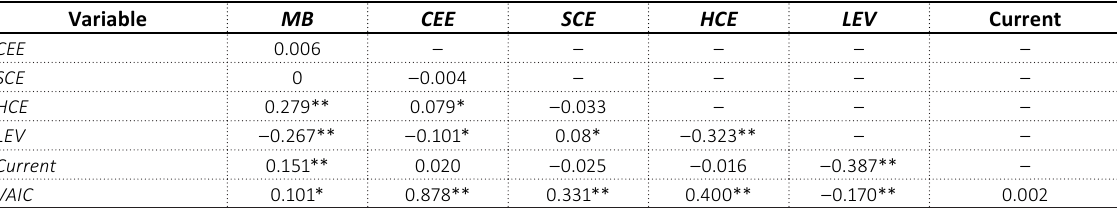
Table 2. Correlation